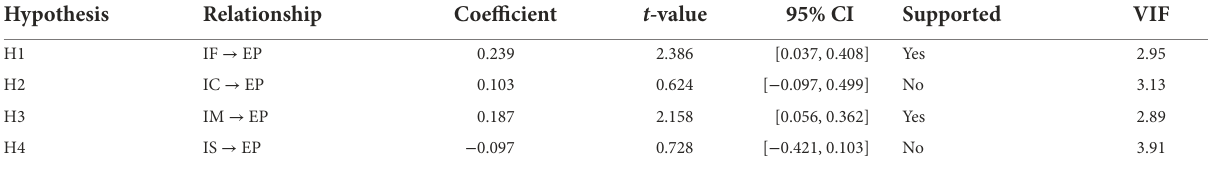
TABLE 4 Results of hypothesis testing.